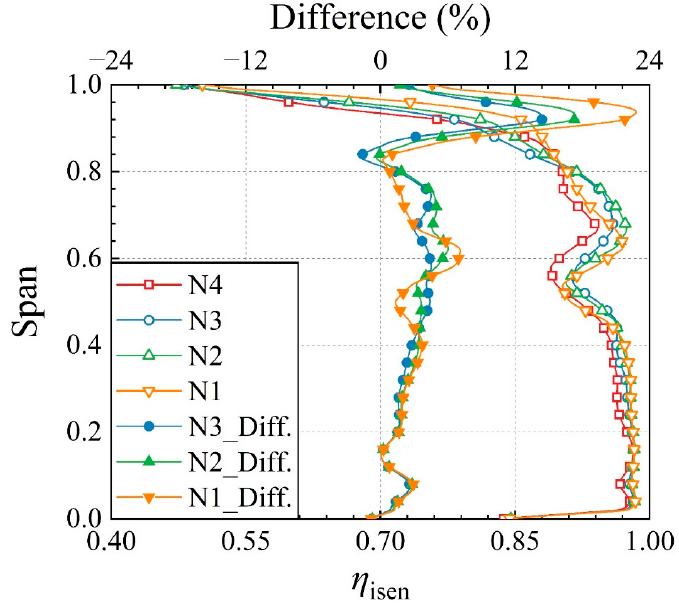
Figure 17. Spanwise distribution of η isen at the stage interface of N1, N2, N3, and N4. The Ma re and entropy contour at 95% span of the tandem rotor at N4 and N1 are demonstrated in Figure 18. Clearly, as the rotating speed decreases, Ma re will transition from supersonic to transonic and gradually break away from the choke condition. Moreover, the strength of the LE shock wave weakens, and the shock wave and boundary layer loss are greatly reduced. On the other hand, the reduction in Ma re leads to decreased loading near the tip, thereby weakening the leakage strength and further reducing the loss. Therefore, the combined reasons for these two aspects result in the change trend of η isen